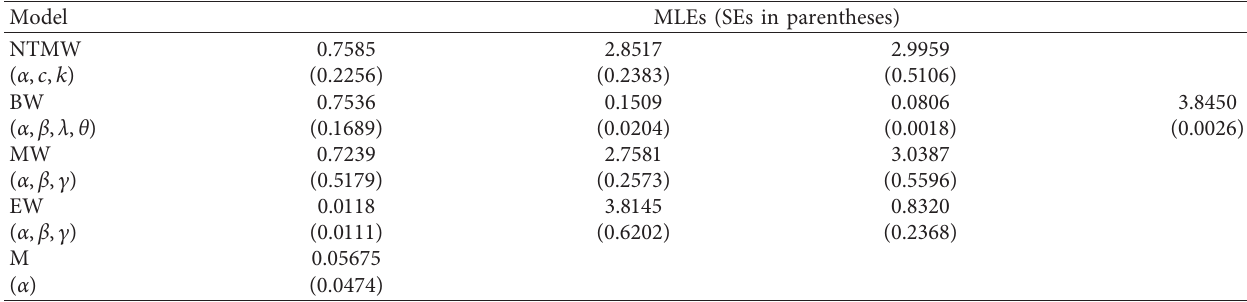
Table 9: Values of the estimates for dataset